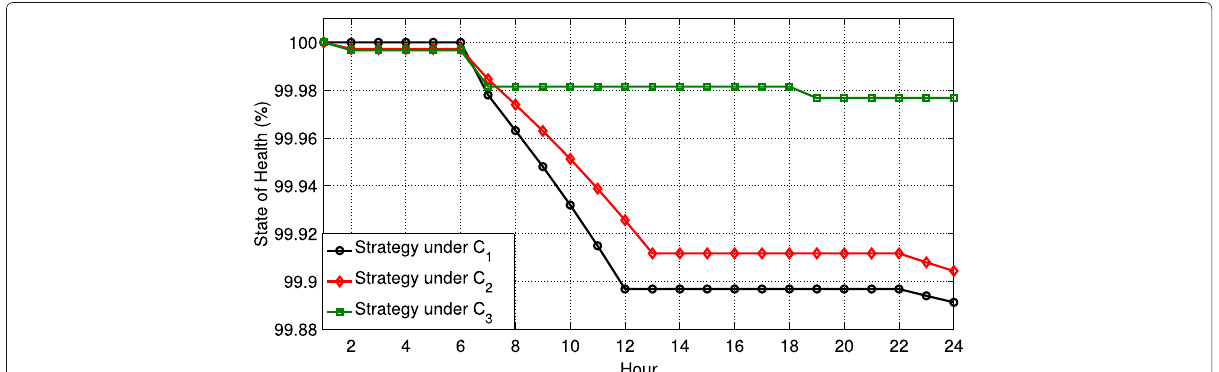
Fig. 10 Average battery calendar aging of the ideal strategy under the constraint sets C 1 , C 2 , and C 3